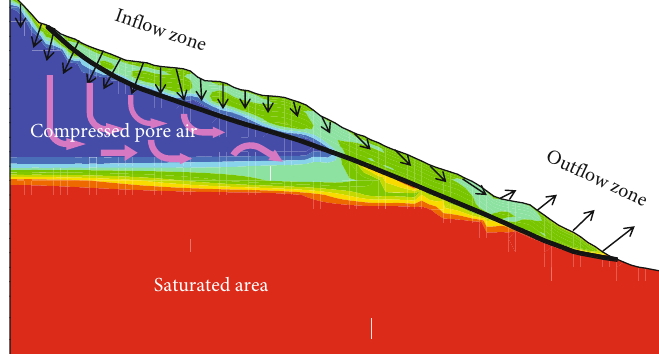
Figure 11: Variation of the factor of safety and rainfall